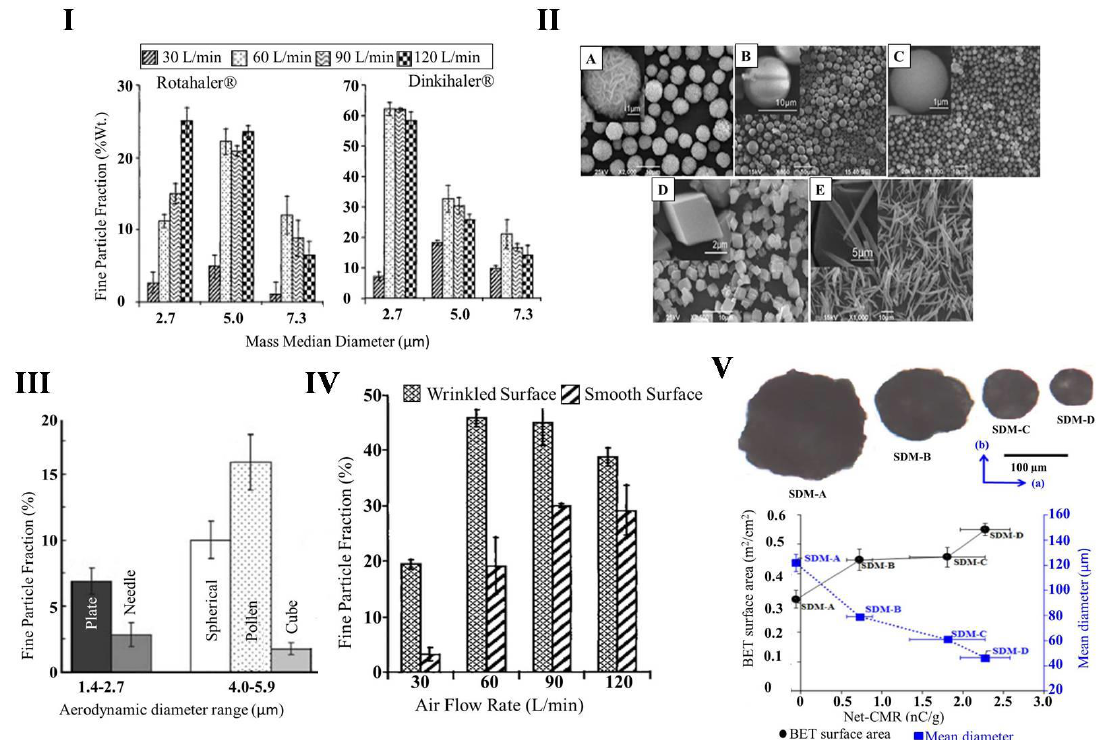
Figure 2. Physicochemical properties of dry powder for inhalation; ( I ) Effect of particle sizes on fine particle fraction (FPF) aerosolized at different air volume. Reproduced with permission from [52], Elsevier, 2000; ( II ) SEM images of differently shaped particles prepared for aerosolization: ( A ) pollen-shaped, ( B ) spherical shaped, ( C ) plate-shaped, ( D ) cube-shaped, and ( E ) needle-shaped particles; Reproduced with permission from [53], Springer, 2009; ( III ) the effects of shape on aero- solization. Reproduced with permission from [53], Springer, 2009; ( IV ) comparison of dispersibility of wrinkled and smooth-surfaced particles at different airflows. Reproduced with permission from [14], Mary Ann Liebert, 2002; ( V ) effects of moisture on ( A ) FPF and ( B ) surface morphology of spray-dried colistin Reproduced with permission from [65], Springer, 2013; ( VI ) net surface charge (nC/g = nanocoulomb/gram,) in relation to volume mean diameter of spray-dried mannitol (SDM-A 90 µm , B 63 µm , C 45 µm , and D 20 µm ) Reproduced with permission from [70], Springer, 2013.